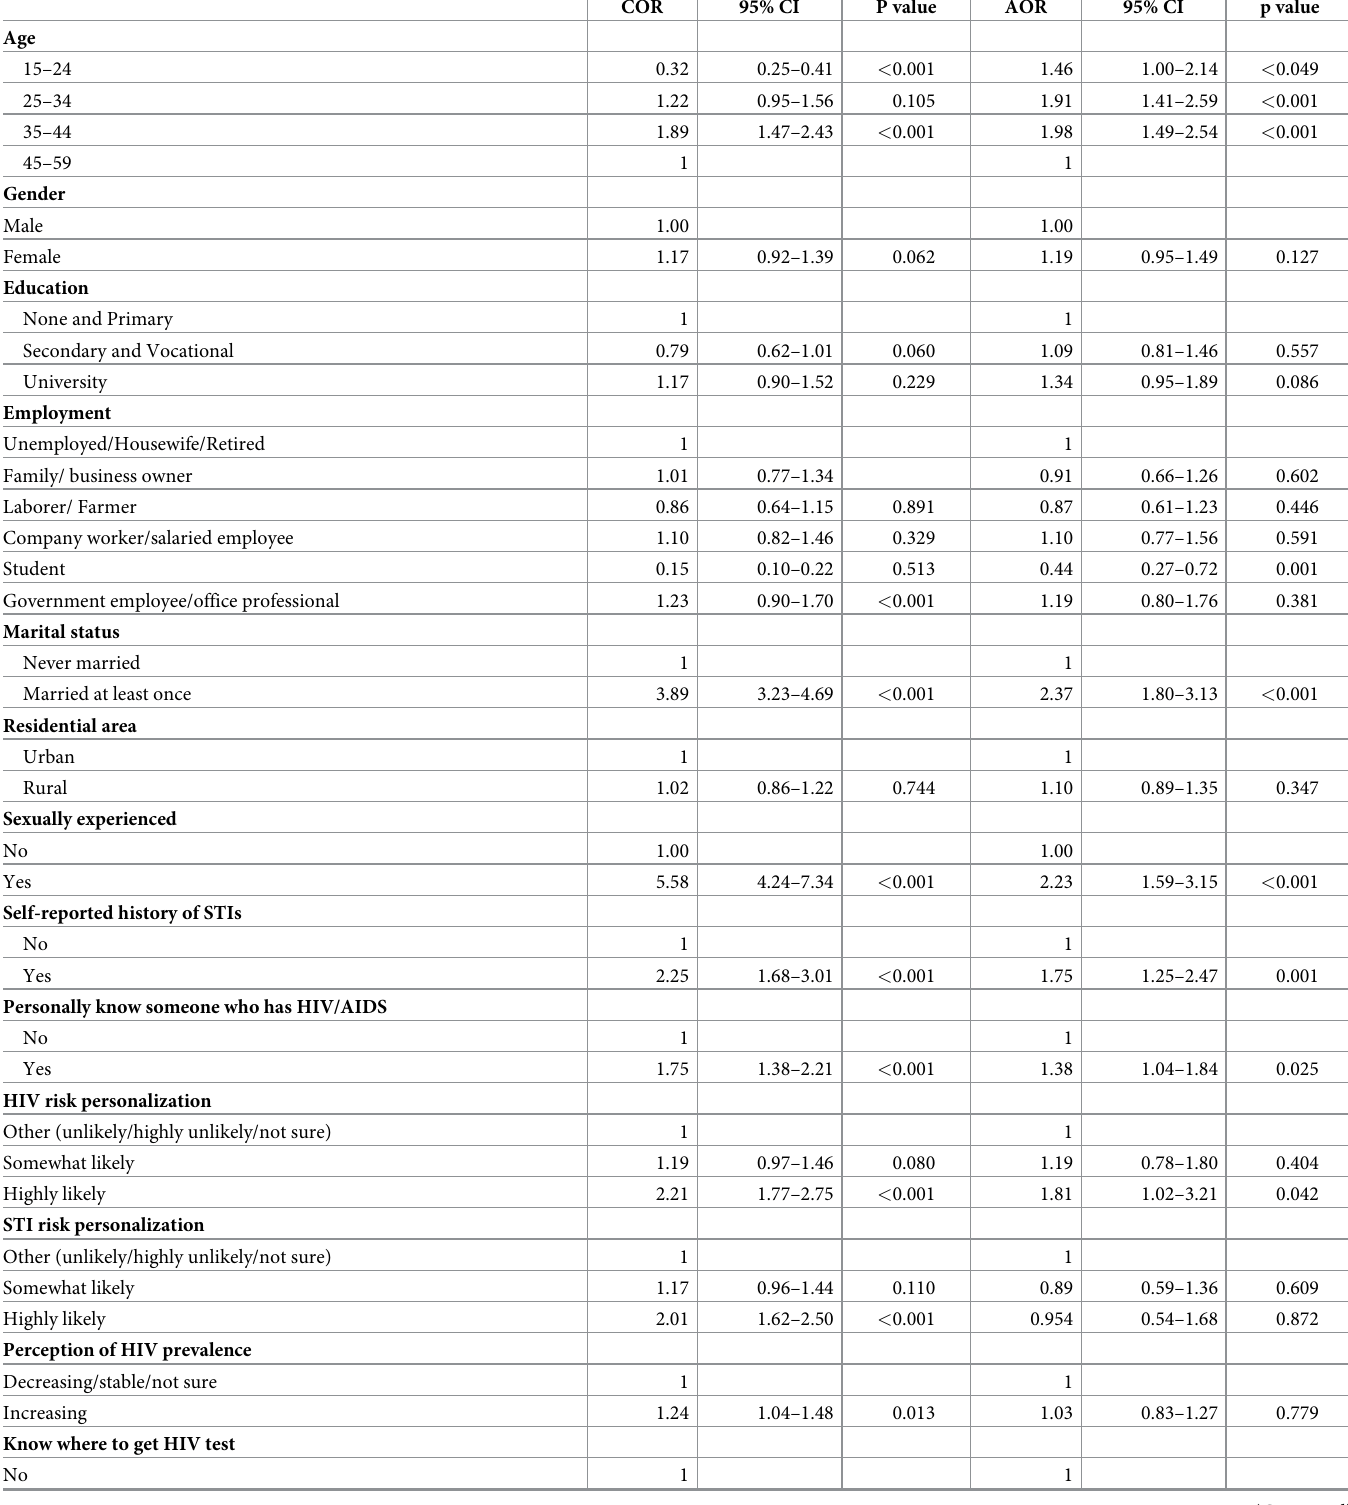
Table 2. Bivariate and multivariable logistic regression of factors associated with HIV